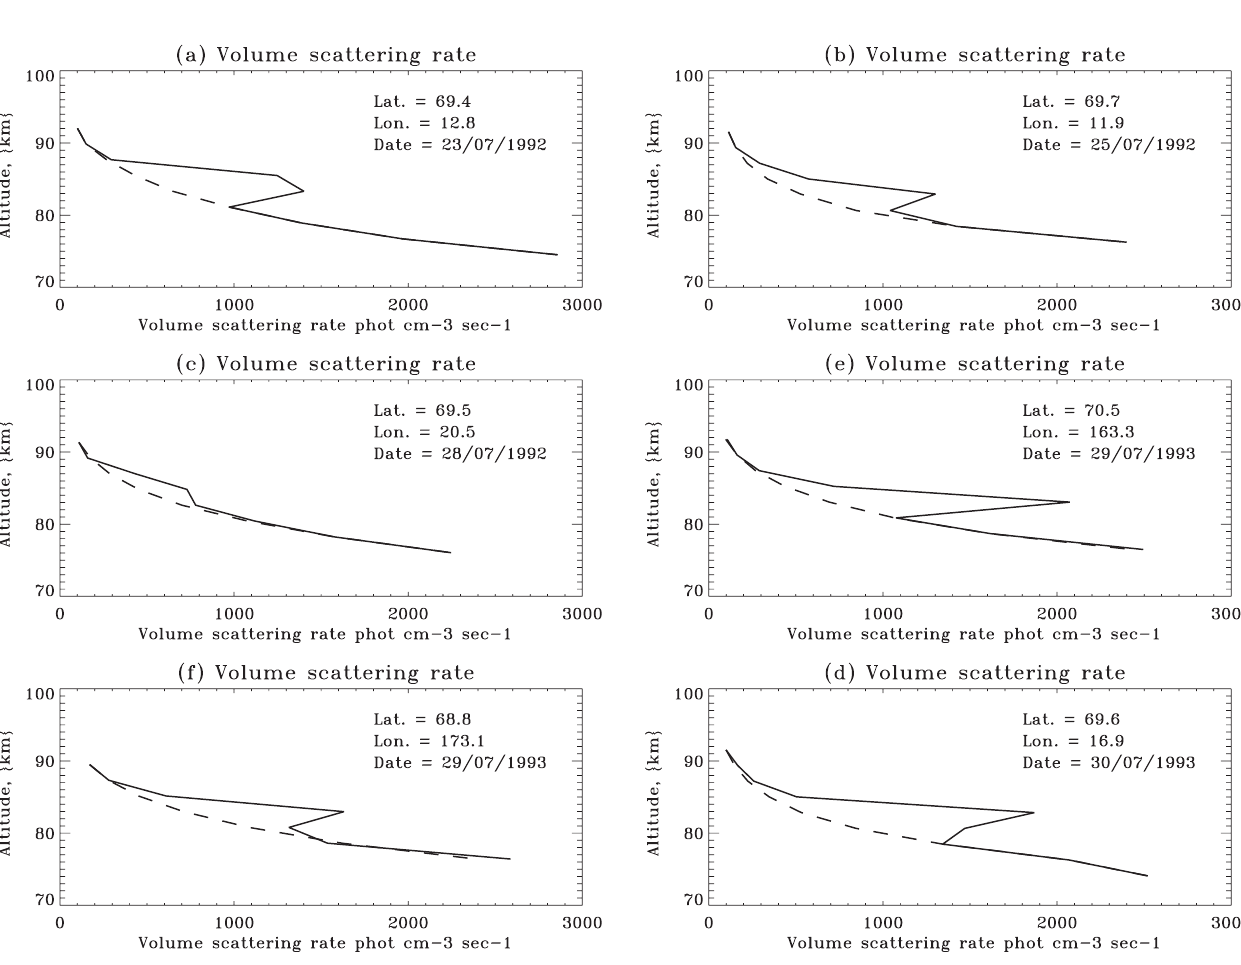
Fig. 4. (a–f) The vertical profiles of the volume scattering radiances in the presence of PMC, used in the model simulations of the BSR (solid line). The volume Rayleigh scattering radiances for a cloud-free atmosphere are given by a dashed